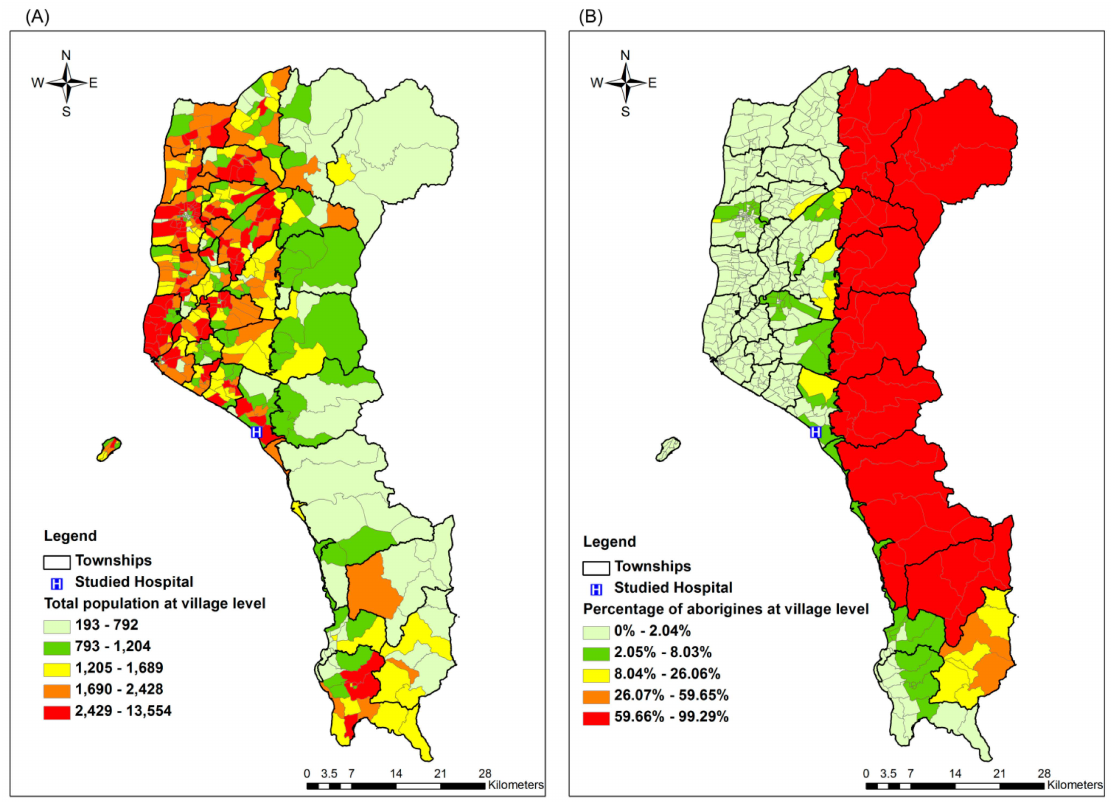
Figure A2. The spatial distribution of the total population in Pingtung county, and percentage of aborigines at village